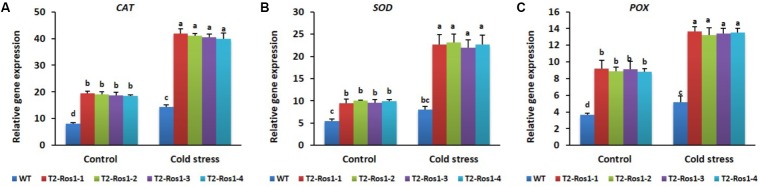
Expression analysis of the antioxidant-related genes (A, CAT; B, SOD; C, POX) in the 9-week-old WT and four independent T2-Ros1 lines under cold stress and normal growth conditions. Data were taken on the 21st day after starting the experiments. NtActin gene was used as reference gene to normalize the transcript levels of the genes. Error bars indicate the SE of means of three replicates. Means with different letters are significantly different (DMRT, p < 0.05).